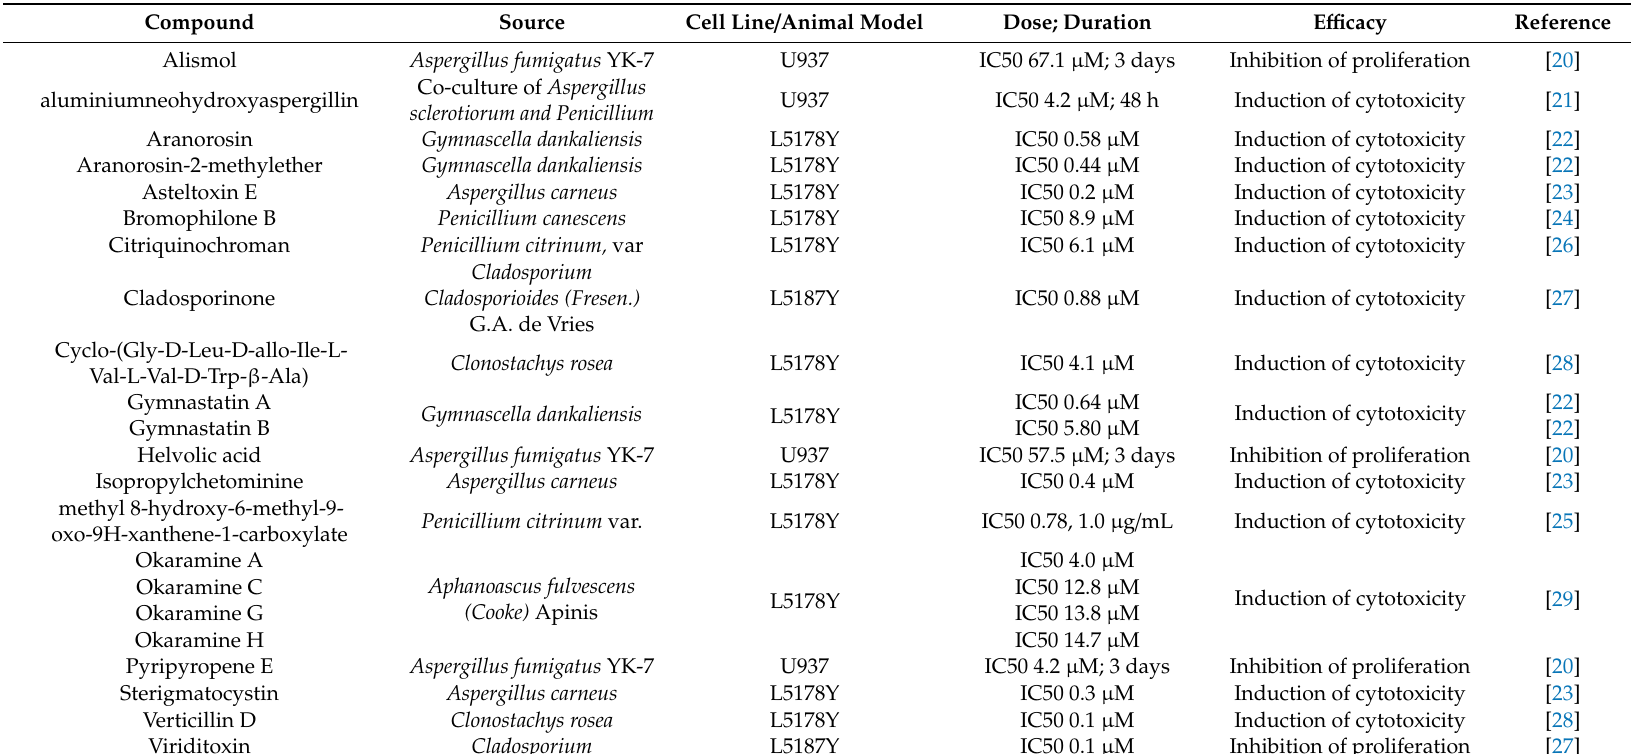
Table 1. Microorganism-derived compounds and